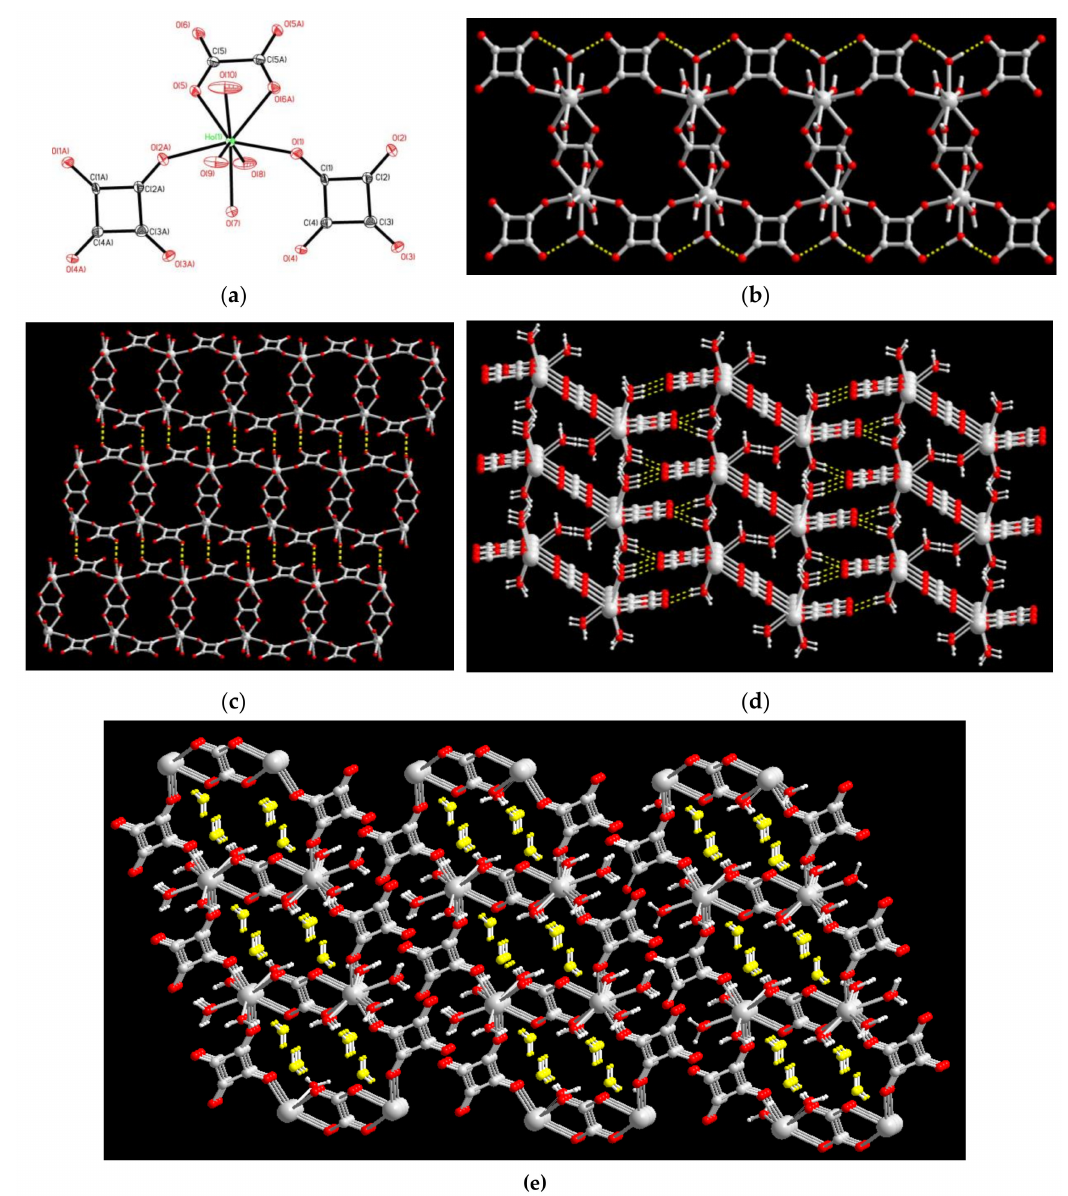
Figure 1. ( a ) Coordination environments of Ho(III) ion in 1 with atom labelling scheme (ORTEP drawing, 30% thermal ellipsoids). The guest water molecules and H atoms are omitted for clarity. ( b ) The 1D ladder-like framework constructed via the bridges of Ho(III) ions and C 2 O 42 − , C 4 O 42 − ligands. ( c ) The 2D layered framework constructed via inter-ladder O − H ··· O hydrogen bonds (yellow dashed lines) between the squarate ligands and coordinated water molecules. ( d ) The 3D supramolecular assembly of 1 via the assembly of 1D ladder-like Chains. (Yellow dashed lines for inter-ladder O − H ··· O hydrogen bonds) ( e ) The 3D supramolecular assembly of 1 viewing along the a axis showing the guest water molecules (yellow color) intercalated into the 1D pores. (red for O atom, and gray-white for Ho and C atoms; yellow color for water molecules; yellow dashed lines for O − H ··· O hydrogen